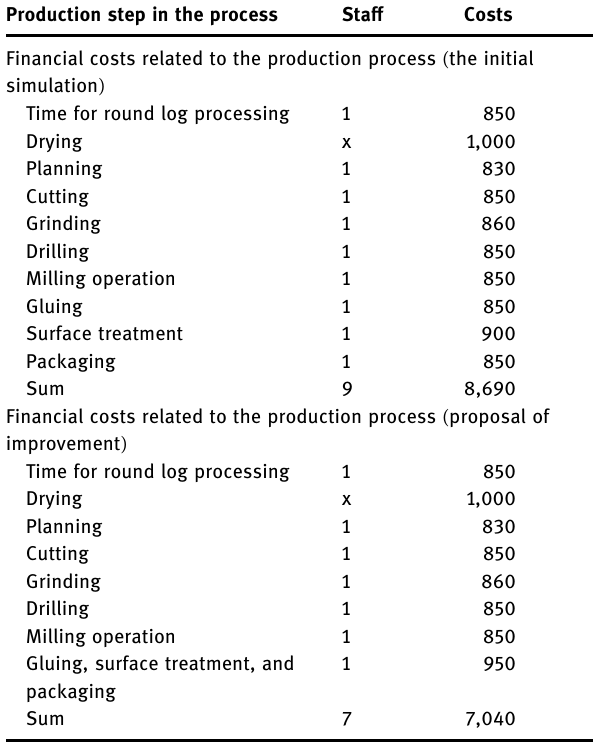
Production step in the process